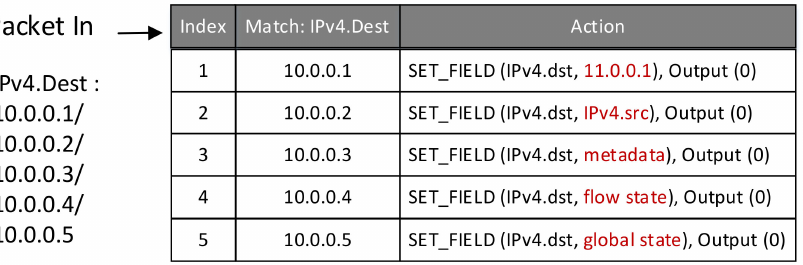
Figure 8. Flow table used in experiment 1.